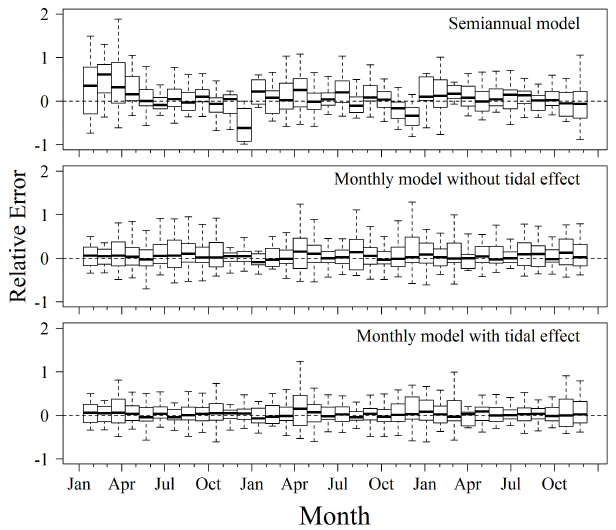
Fig. 6. Relative errors of monthly model (with and without tidal effect) and semiannual model. Compared to the semiannual model (top), the monthly models (bottom and middle) have smaller relative error, and the median of each bin is close to zero. The semiannual model overestimates the respiration in spring and underestimates that in winter. Including the tidal effect in the monthly model helps to reduce the error for summer (bottom vs.